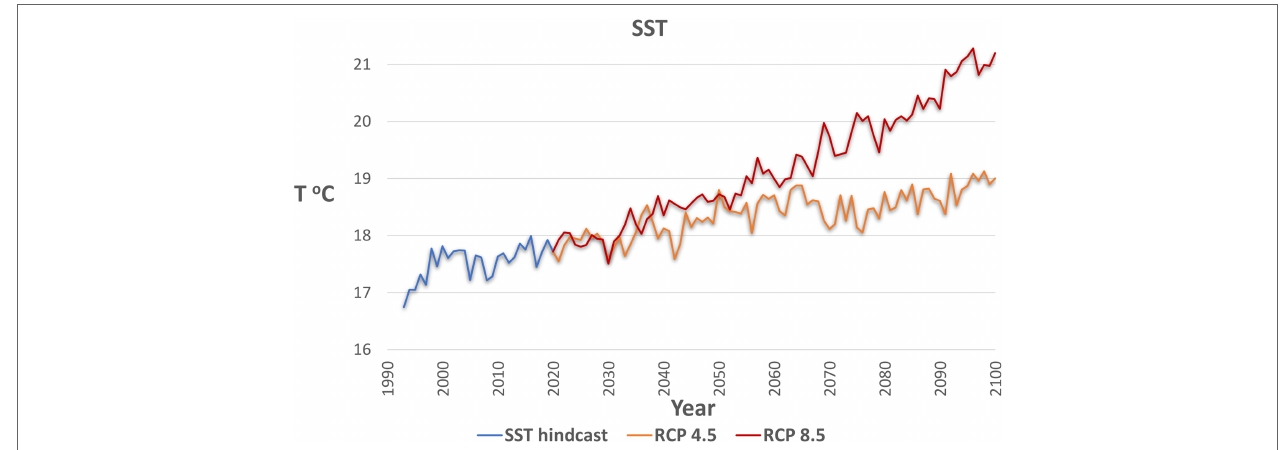
FIGURE 4 | Sea Surface Temperature (SST) of the model area during the hindcast period (1993-2020) and under the two climate scenarios considered (RCP 4.5 and RCP 8.5) for the period